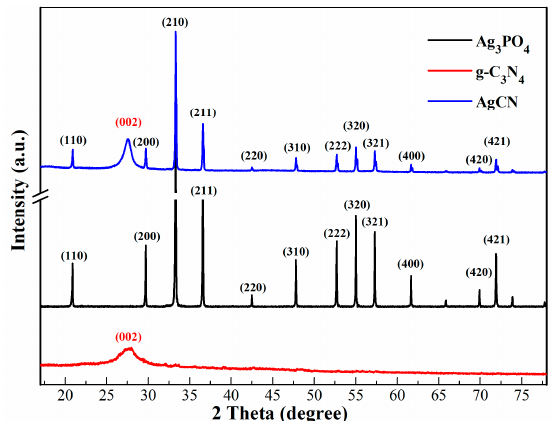
Figure 1. XRD patterns of the synthesized Ag 3 PO 4 (black line) and g-C 3 N 4 (red line) and AgCN (blue line) composite.